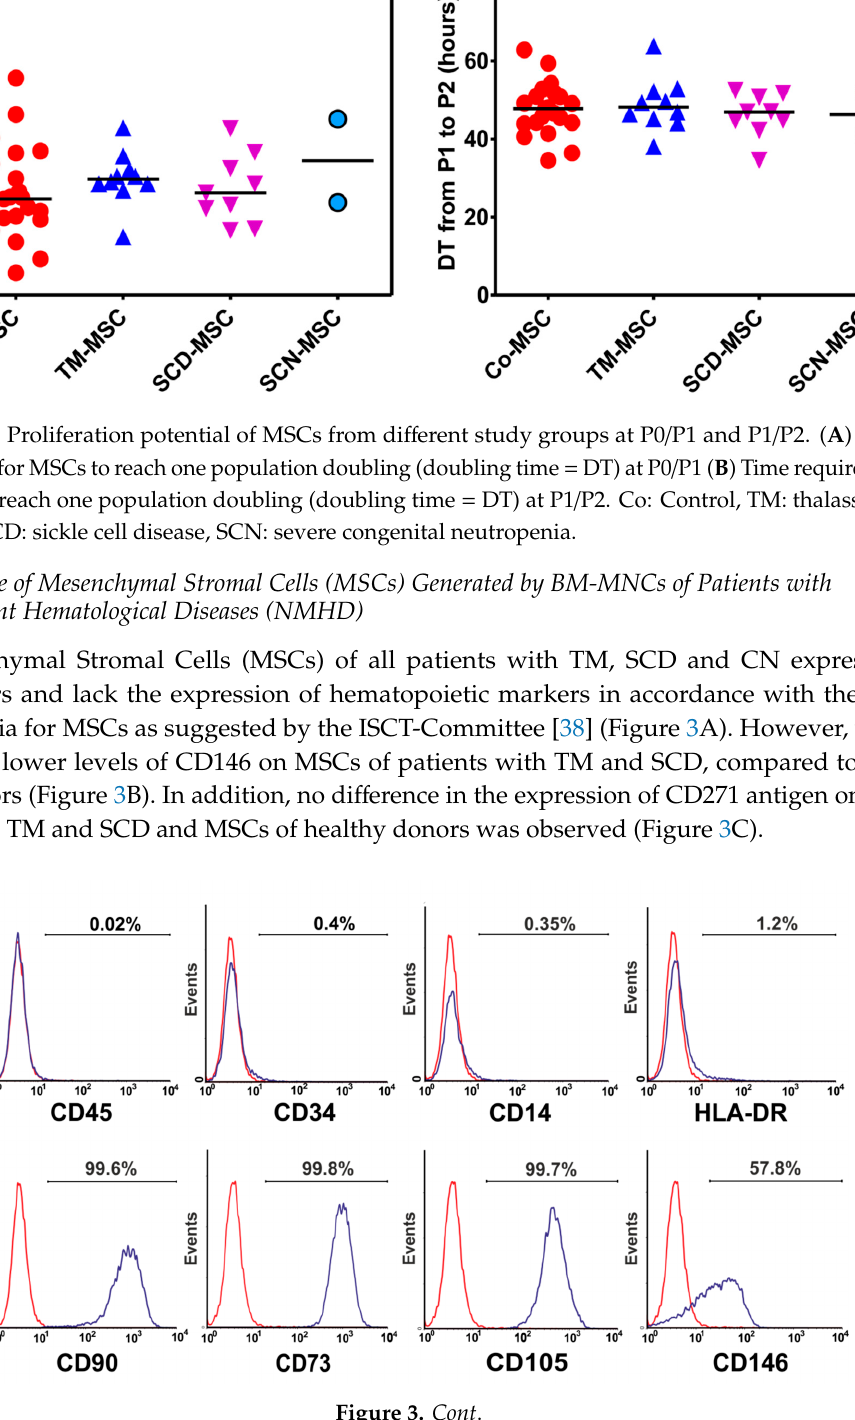
Figure 3. The phenotype and differences in the expression of CD146 and CD271 antigens on MSCs of patients with NMHD. ( A ) Phenotype of passage 2 MSCs in a patient with TM. MSCs were immunostained with fluorochrome-conjugated monoclonal antibodies and incubated at 4 °C for 30 min. After two wash steps with PBS + 0.2% BSA the stained cells were analyzed on a FACSCalibur (Becton-Dickinson, Heidelberg) equipped with Macintosh software for data analysis (CellQuest). At least 50.000 events were acquired for each measurement. ( B ) Expression of CD146 antigen on MSCs of passage 2 in patients with TM (68.2% (43.8–89.3), N = 10) and SCD (68.7% (46.7–75.4) N = 9)) was significantly lower than in MSCs of healthy controls (97.65% (80.6–99.8), N = 12, P < 0.0001). ( C ) Passage 2 MSCs of patients with non-malignant hematological diseases expressed similar levels of CD271 antigen as MSCs of healthy donors. Co: Control, TM: thalassemia major, SCD: sickle cell disease, SCN: severe congenital neutropenia. 3.5. Trilineage Differentiation Potential of Mesenchymal Stromal Cells (MSCs) of Patients with Non-Malignant Hematological Diseases (NMHD) Mesenchymal Stromal Cells (MSCs) of Non-Malignant Hematological Diseases (NMHD) differentiate equally well as healthy donors into osteoblasts, adipocytes and chondrocytes.